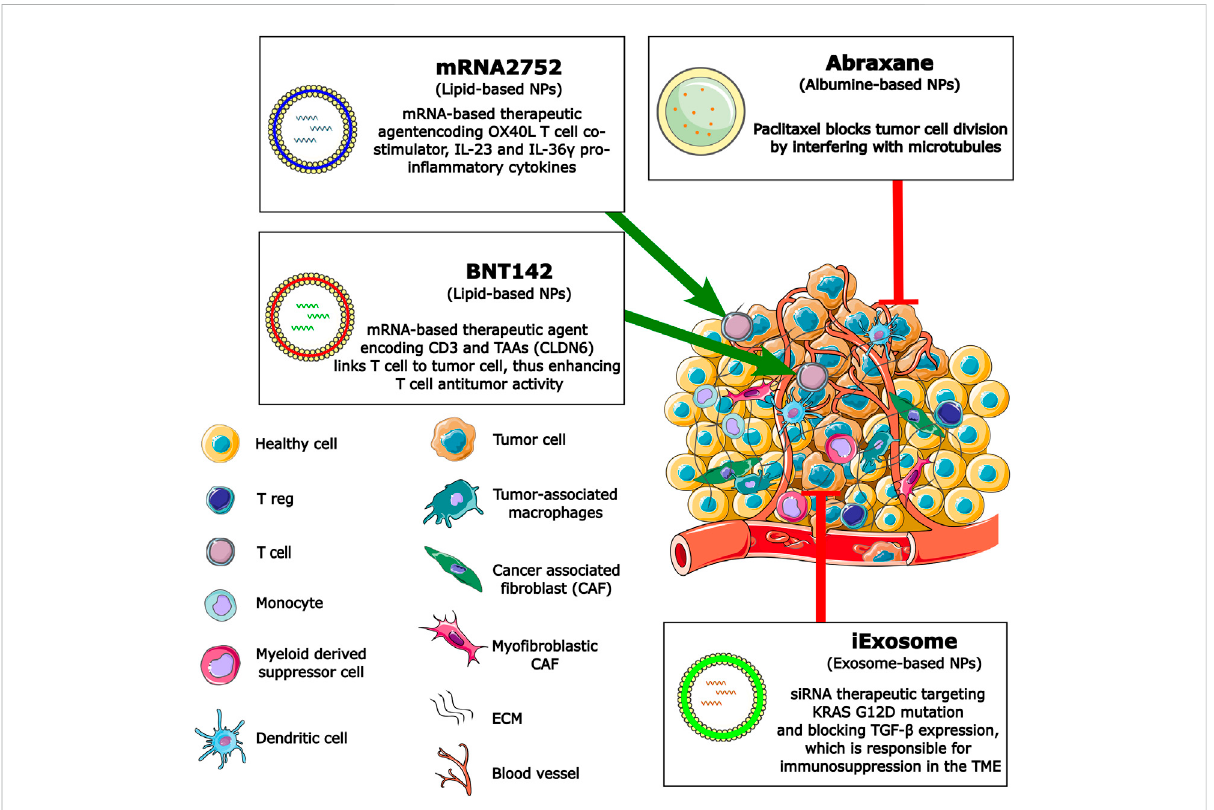
FIGURE 3 Schematic representation of NP strategies used to overcome and remodulate the TME or reactivate antitumor T cell activities in PC.